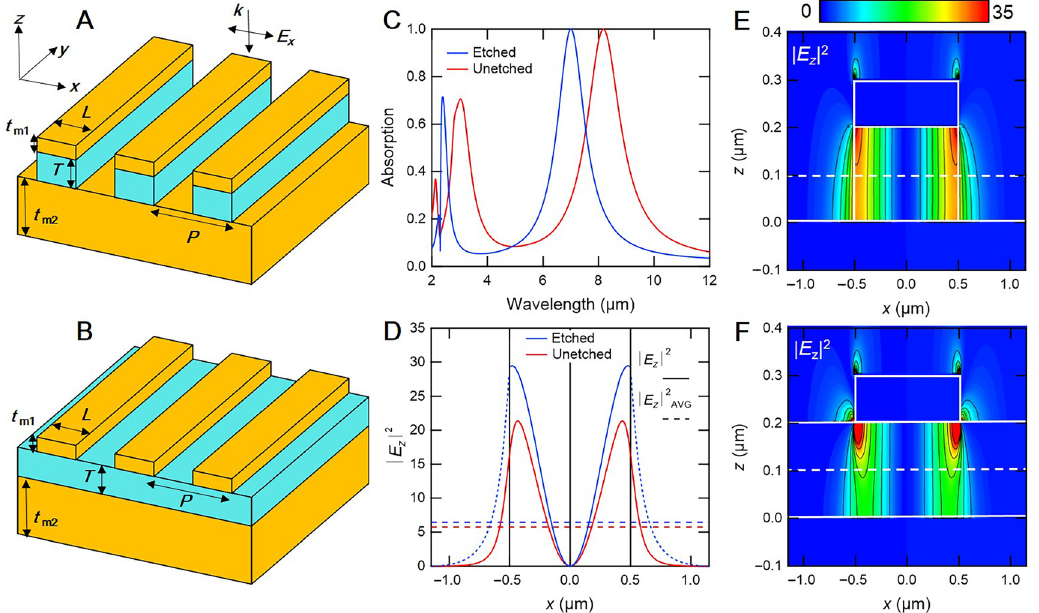
Figure 1: Modelingof stripe cavity structure. A, B) Schematics of etchedandunetchedstructures. k and E indicate theincidencedirectionand polarization of incoming light. C) Simulated absorption pro fi les for both structures with L = 1.0 μ m and P = 2.3 μ m. D) Magnitude and average (cid:1)(cid:1)(cid:1)(cid:1) (cid:1)(cid:1)(cid:1)(cid:1) 2 withinoneperiod P foreachstructuretakenat z =0.1 μ m,normalizedtotheincident fi eld.Notedottedareasoftheetchedcurve valuesfor E z (blue) indicate regions with no semiconductor material. E, F) Color maps of linesindicatethecavityshape,withthedashedlineindicatedthepositionofthequantumwell.Contourlinesaretakenateveryincreaseof fi ve in intensity (5, 10, …